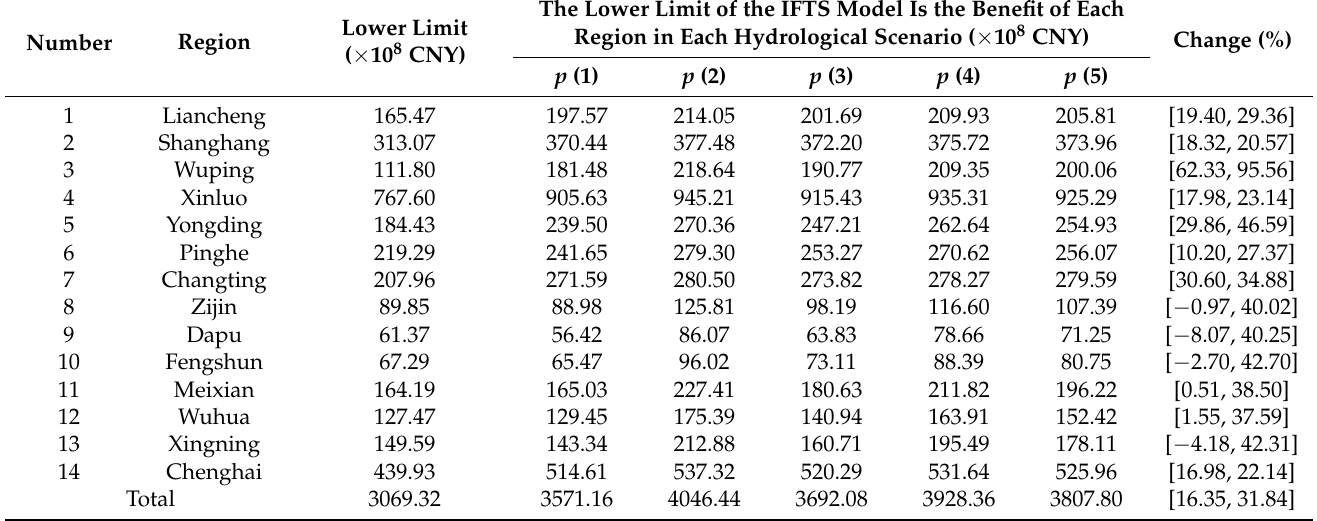
Table 3. Economic benefits of each administrative unit simulated by the IFTS model under different hydrological scenarios (lower